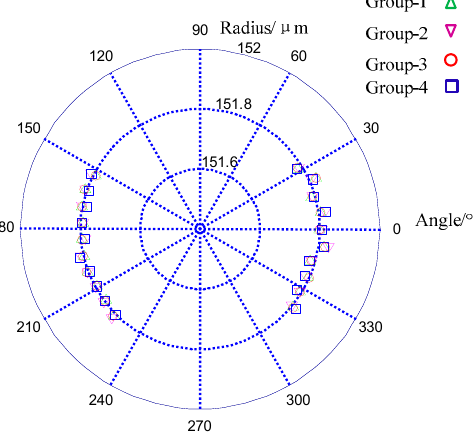
Figure 13. Repeatability measurement of a cross section profile.